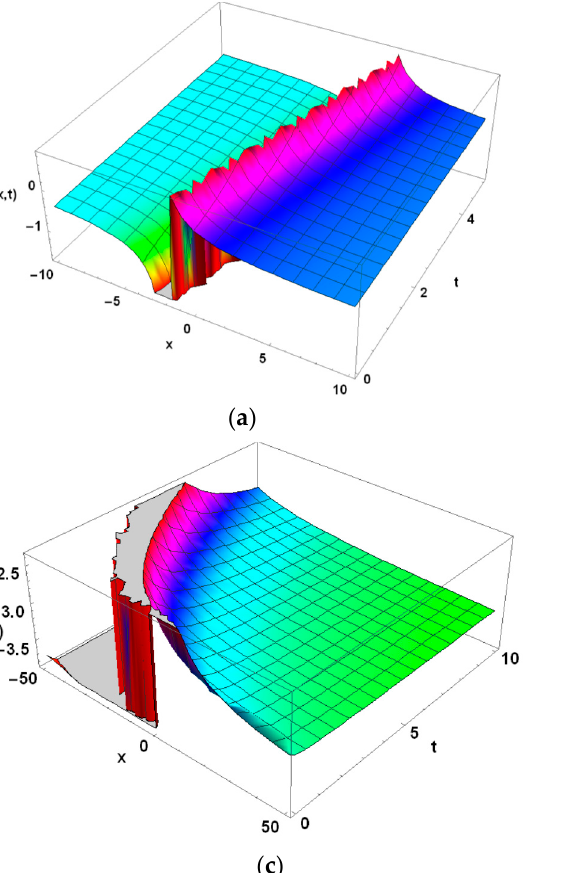
Figure 5. For Equation (32), ( a – d ) with 0 ≤ x ≤ 10 and 0 ≤ t ≤ 5 indicate the 3D profiles, ( e – h ) represent the contour profiles for 0 ≤ x ≤ 10 and 0 ≤ t ≤ 5, and ( i ) indicates the 2D representation of a range of values of α . ( a ) α = 1, ( b ) α = 0.8, ( c ) α = 0.5, ( d ) α = 0.25, ( e ) α = 1, ( f ) α = 0.8, ( g ) α = 0.5, and ( h ) α = 0.25.